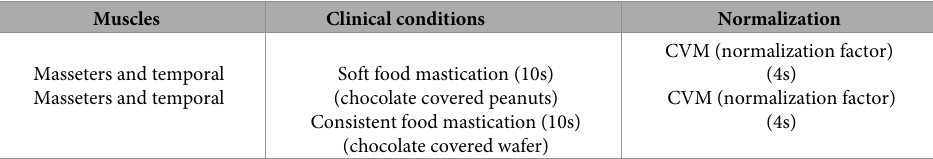
CVM (normalization factor) (4s)